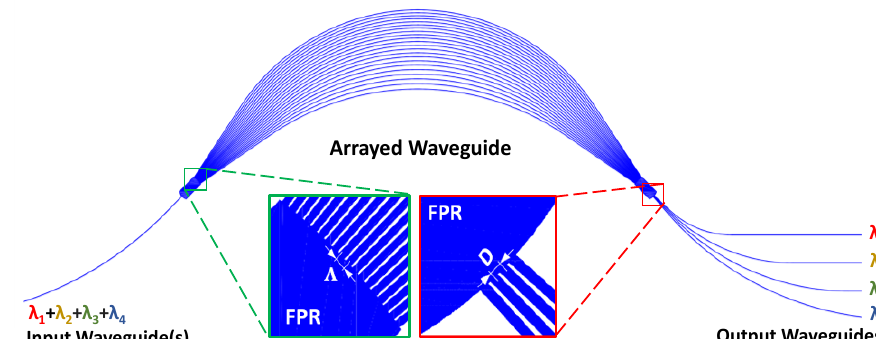
Fig. 2. Schematic of the SLSW-based AWG